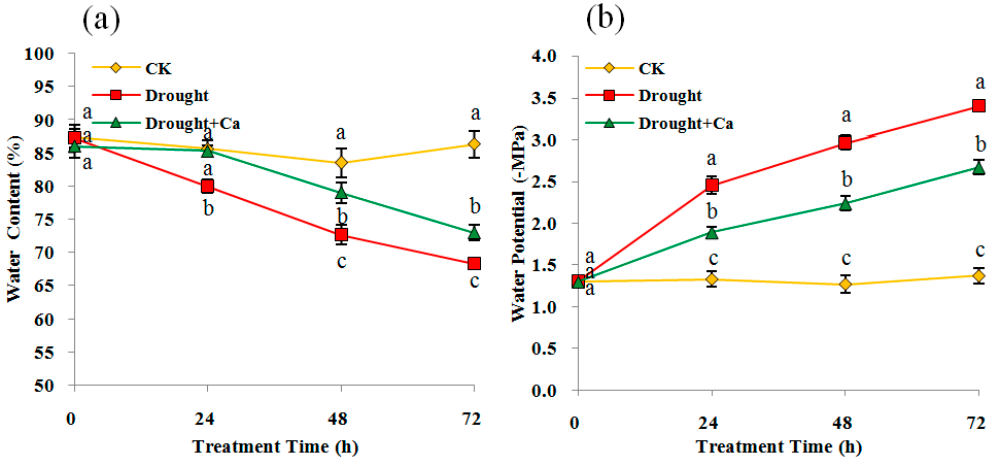
Figure 2. ( a ) Relative water content (RWC), ( b ) Water potential (WP) in C. glauca leaves under drought stress and amended with Ca 2+ . Different small letters indicate a significant difference between treatments ( p < 0.05) within each sampling time. Control group with no drought or Ca 2+ treatment, CK; Drought-treated plants with no Ca 2+ amendment, Drought; and Ca 2+ amended drought-treated plants, Drought + Ca. All data show the means ± SD of three replicates.